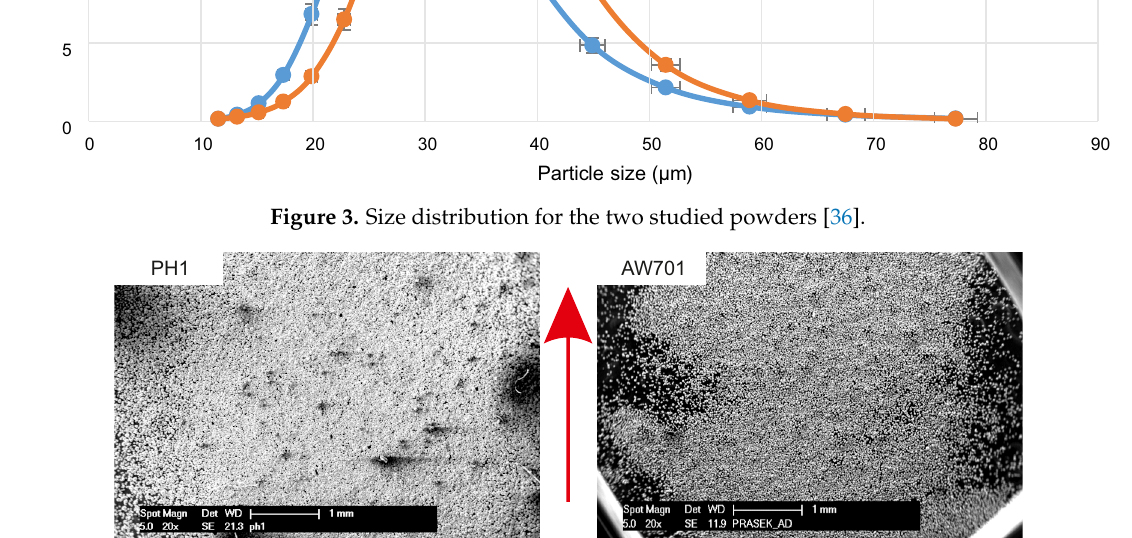
Figure 4. Micrographs of spread test on the build plate of the AM machine. The arrow indicates the direction of movement of the recoater blade.